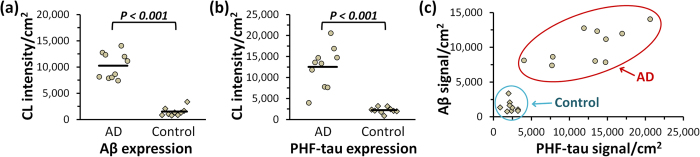
Same-sample quantitative analysis of Aβ and PHF-tau abundance in brain tissue sections.FFPE brain tissue sections from “Alzheimer′s disease (AD)” (n = 10) and healthy “Control” (n = 9) groups were simultaneously labeled for Aβ and PHF-tau pathologic proteins. AP reporters corresponding to each target were sequentially released via DNA displacement and measured with a plate reader. Chemiluminescence signal was normalized by the gray matter area on each tissue section. (a) Comparison of Aβ expression in “AD” and “Control” groups. (b) Comparison of PHF-tau expression in “AD” and “Control” groups. Average expression level is indicated by a solid line on each scatter plot. (c) Pairwise comparison of Aβ and PHF-tau expression in “AD” (circles) and “Control” (diamonds) groups.